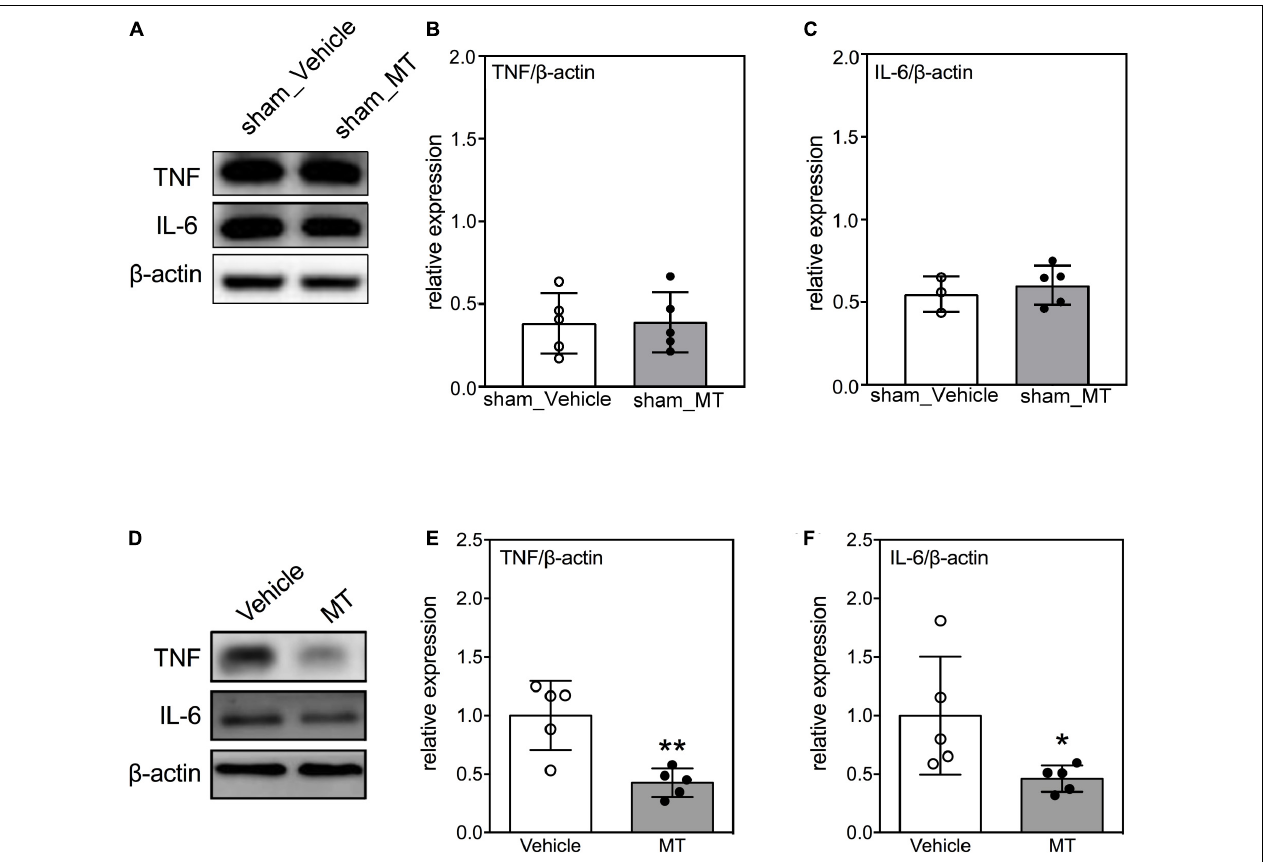
FIGURE 5 | Effects of mitochondrial transplantation on expression of pro-inflammatory cytokines in the injured spinal cord of rats with traumatic SCI on PID 1. (A) Representative micrograph of Western blots of TNF and IL-6 in sham control groups. (B,C) Quantitative results of relative expression of TNF and IL-6 in sham control groups. (D) Representative micrograph of Western blots of TNF and IL-6 in SCI groups on PID 1. (E,F) Quantitative results of relative expression of TNF and IL-6 in SCI groups on PID 1. The 1-cm spinal cord specimens centered at the epicenter of the injured site were used in Western blots. Data were expressed as mean ± standard deviation. * p < 0.05, ** p < 0.01, two-tailed Student’s t -test. N = 3–5. MT, mitochondria